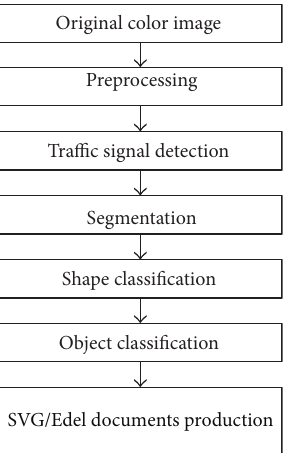
Figure 3: Outline for hand-drawn map